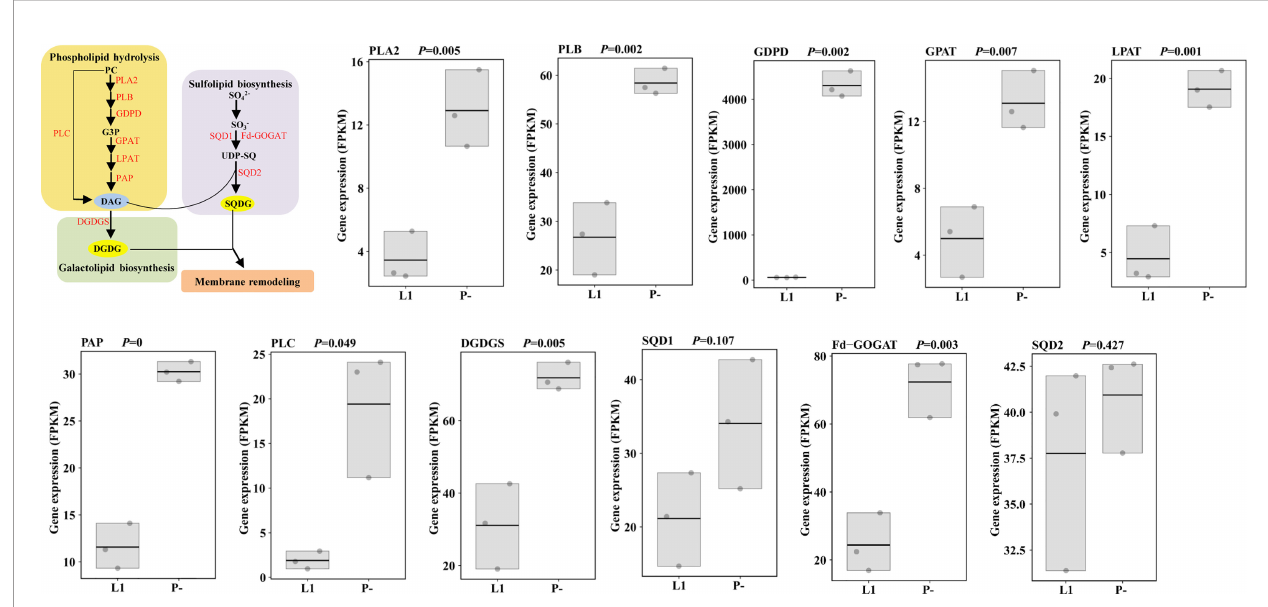
FIGURE 2 | Membrane remodeling under P-limitation (P-) compared to P-replete condition (L1) and the corresponding gene expression. Processes of phospholipid hydrolysis, and galactolipid and sulfolipid biosynthesis were up-regulated characterized by the up-regulation of the responsible enzymes (in red color). PC, phosphatidylcholine; PLA2, secretory phospholipase A2; PLB, lysophospholipase/phospholipase B; GDPD, glycerophosphodiester phosphodiesterase; G3P, (sn)-glycerol-3-phosphate; GPAT, glycerol-3-phosphate acyltransferase; PA, phosphatidic acid; PAP, phosphatidic acid phosphatase; DAG, diacylglycerol; PLC, phospholipase C; DGDG, digalactosyldiacylglycerol; DGDGS, digalactosyldiacylglycerol synthase; SQDG, sulfoquinovosyldiacylglycerol; SQD1, UDP-SQ synthase; UDP-SQ, UDP-sulfoquinovose; Fd-GOGAT, ferredoxin-dependent glutamate synthase; SQD2, SQDG synthase; RuBP, ribulose-1,5-bisphosphate; RuBisCo, ribulose-1,5-bisphosphate carboxylase-oxygenase; PK, phosphoglycerate kinase; GAPDH, glyceraldehyde 3-phosphate dehydrogenase; 1,3BPGA, 1,3-bisphosphoglycerate; G3P, glyceraldehyde 3-phosphate; PEP, phosphoenolpyruvate; PEPC, PEP carboxylase; OAA, oxaloacetic acid; PEPCK, phosphoenolpyruvate